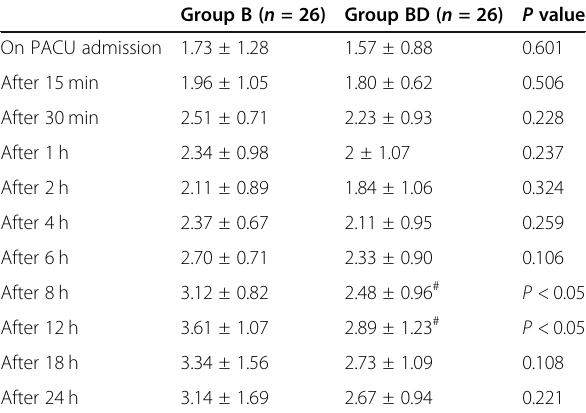
Table 6 Postoperative pain